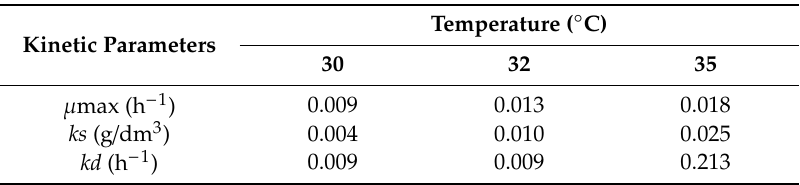
Table 4. Determined kinetic parameters for bioethanol